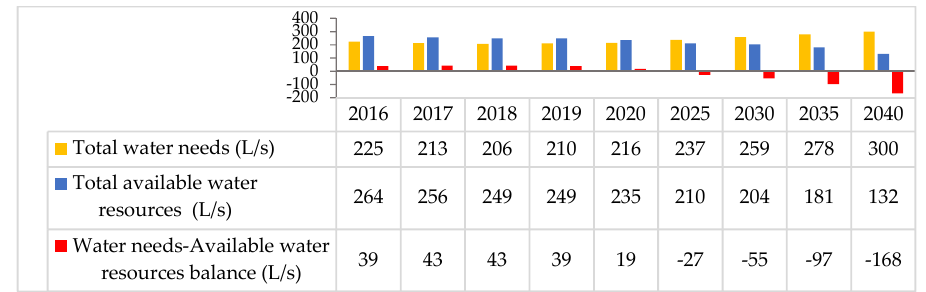
Figure 6. Estimation of drinking water needs—available water resources balance sheet of Taourirt municipality (Pessimistic scenario).